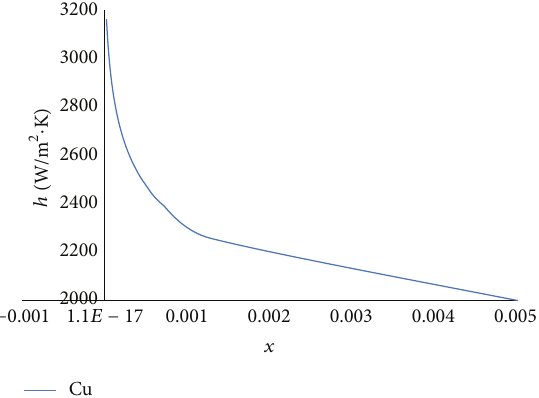
Figure 9: Variation of heat transfer coefficient against quality for nanofluid with copper nanoparticle.